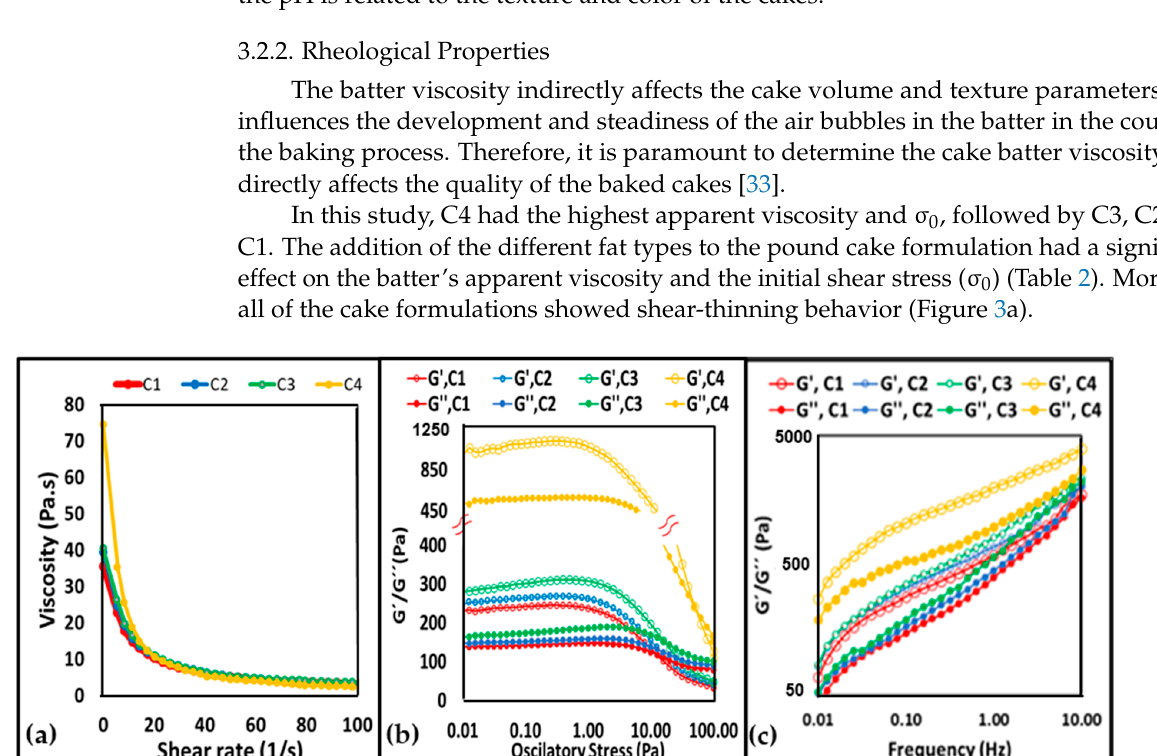
Figure 4. Slices of the cakes made with different fats. C1, C2, and C3 contained fats E1 (35% CA and 65% CO), E2 (30% CA and 70% CO), and E3 (25% CA and 75% CO), respectively, and control (C4) contained palm oil. The baking loss, specific volume, symmetry index, and color parameters of the cakes made with the different fat types (Table 3) were evaluated 1 day after preparation. No